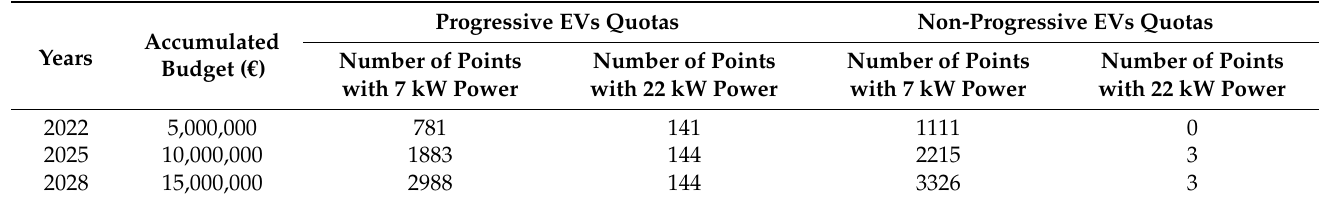
Figure 23. Distribution of charging points in the northeast region of Tenerife with each black dot representing a charging point.